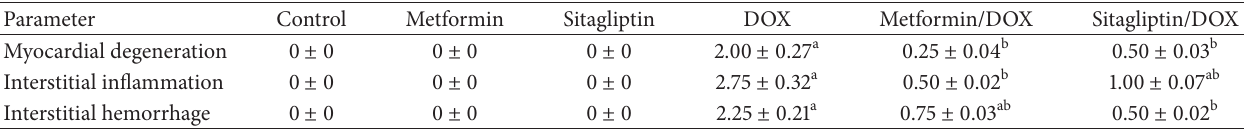
Table 2: Effect of metformin or sitagliptin on the histopathology in DOX-induced cardiotoxicity in rats.